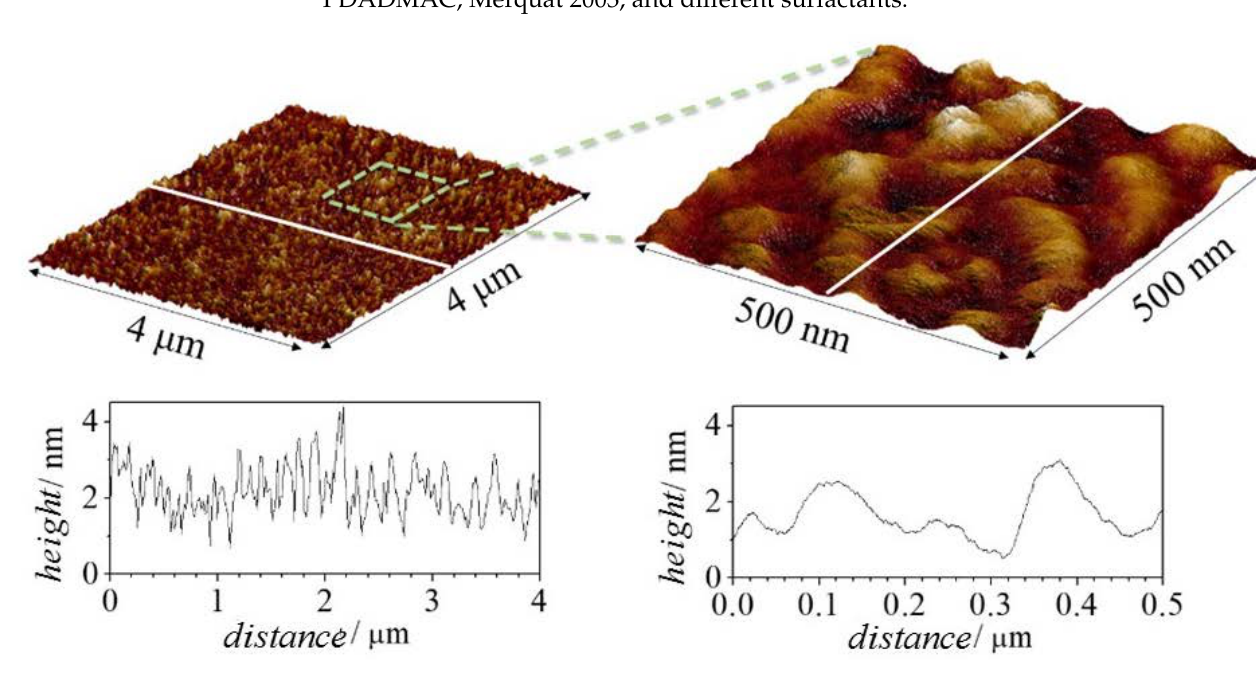
Figure 9. Experimental results obtained by AFM for a layer adsorbed from a diluted Merquat 2003– CAPB solution of df = 5. Three-dimensional topographic images obtained over an area of 4 × 4 μm 2 using a scanning resolution of 15.6 nm/pt ( left image), and over an area of 0.5 × 0.5 μm 2 using a scanning resolution of 1.95 nm/pt ( right image). Below each image is depicted the corresponding height profile performed along the white line.